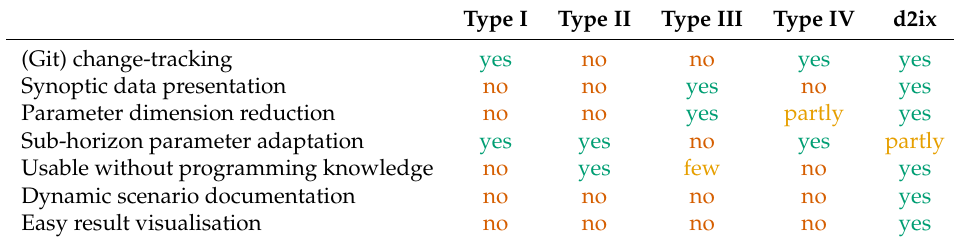
Table 1. Comparison of the input-data-handling types used so far and the new data-handling framework d2ix . The types are described in Section